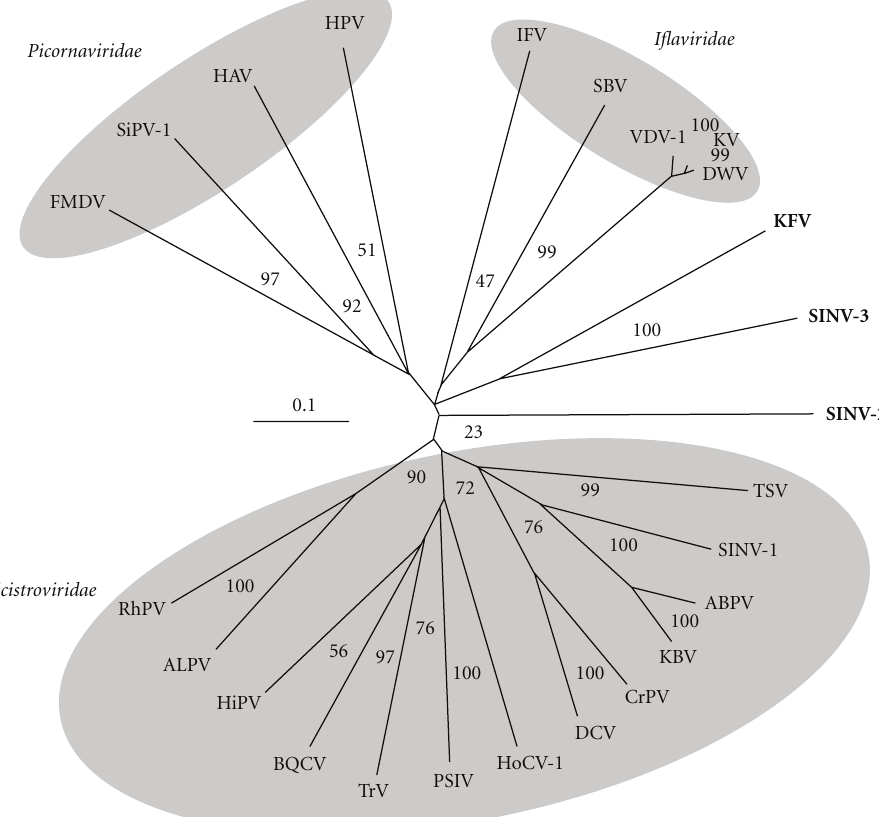
Figure 6: Phylogenetic analysis of the conserved amino acid sequences containing domains I to VIII of the putative RdRp from 13 dicistroviruses, 5 iflaviruses, 4 picornaviruses, and 3 unassigned viruses (bold). Virus abbreviation, Genbank accession number of the virus sequence, and amino acid residues of aligned sequences in a specific ORF (5 (cid:2) proximal ORF of dicistroviruses, otherwise an ORF number is specified) include the following. Aphid lethal paralysis virus (ALPV) [AF536531], 1661–1955; Black queen cell virus